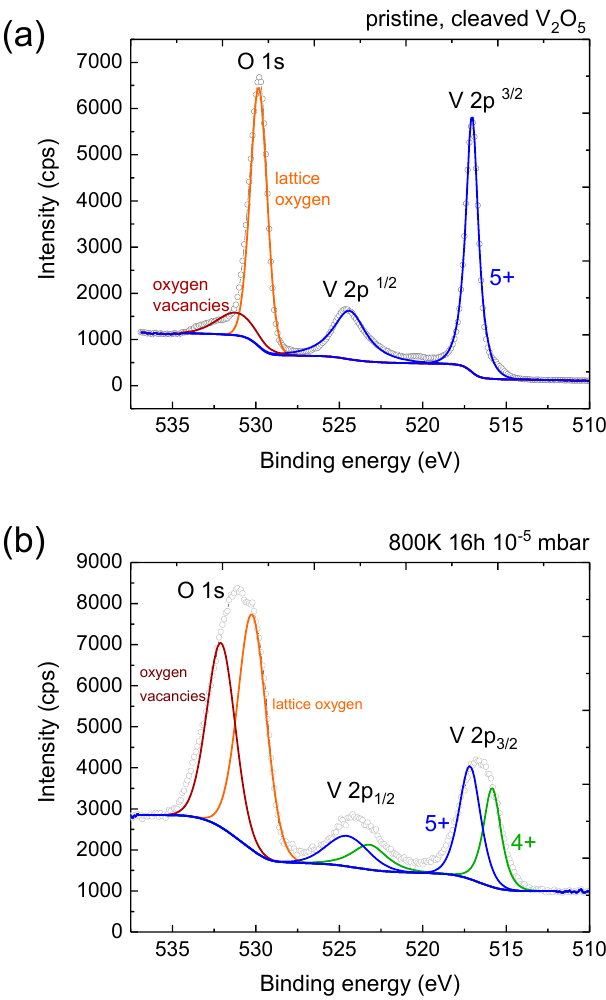
Figure 4. X-ray photoelectron spectra of the cleaved crystal ( a ) and the crystal annealed at 800K for 16h in a pressure of 10 − 5 mbar ( b ). The spectra of the cleaved crystal is characteristic of V 2 O 5 . The annealing results in 4+ contribution to the V2p and an oxygen peak attributed to oxygen